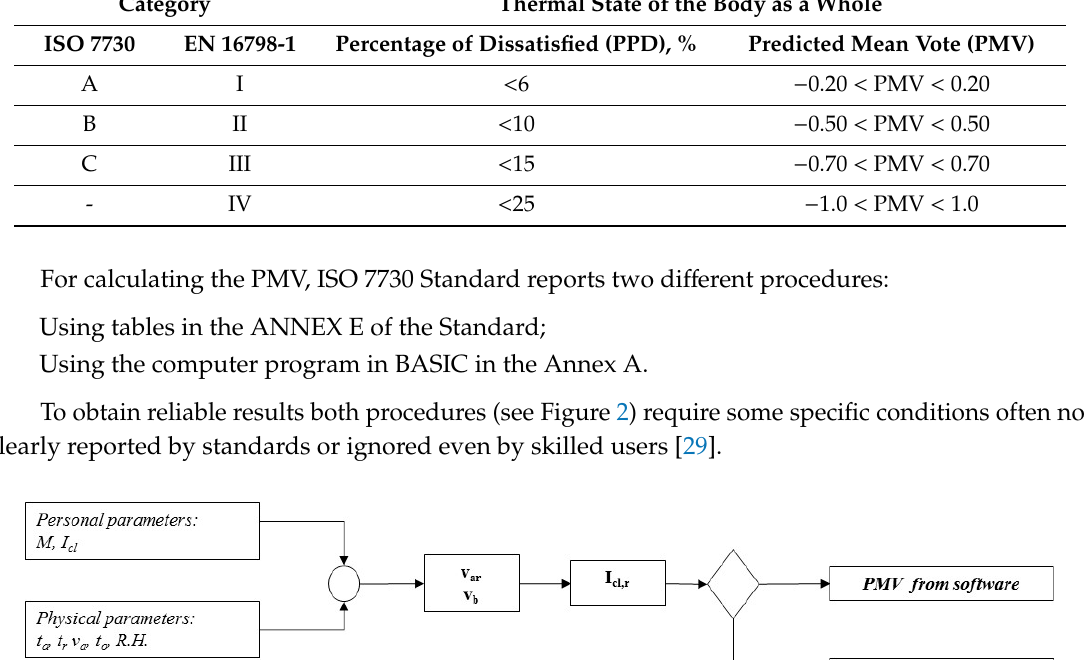
Figure 2. Flow chart for the calculation of PMV as required by ISO 7730 Standard [9].